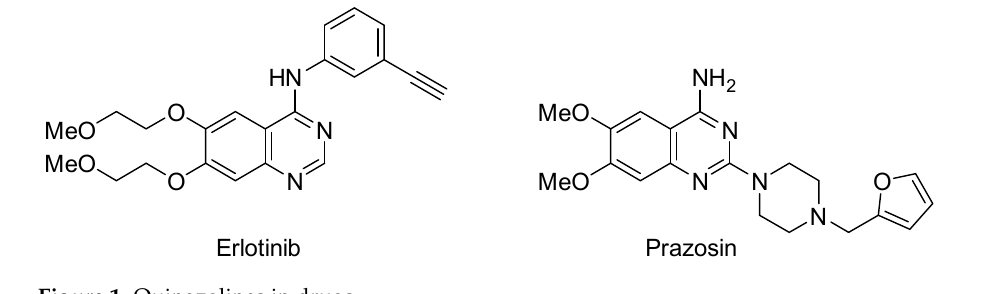
Figure 1. Quinazolines in drugs.